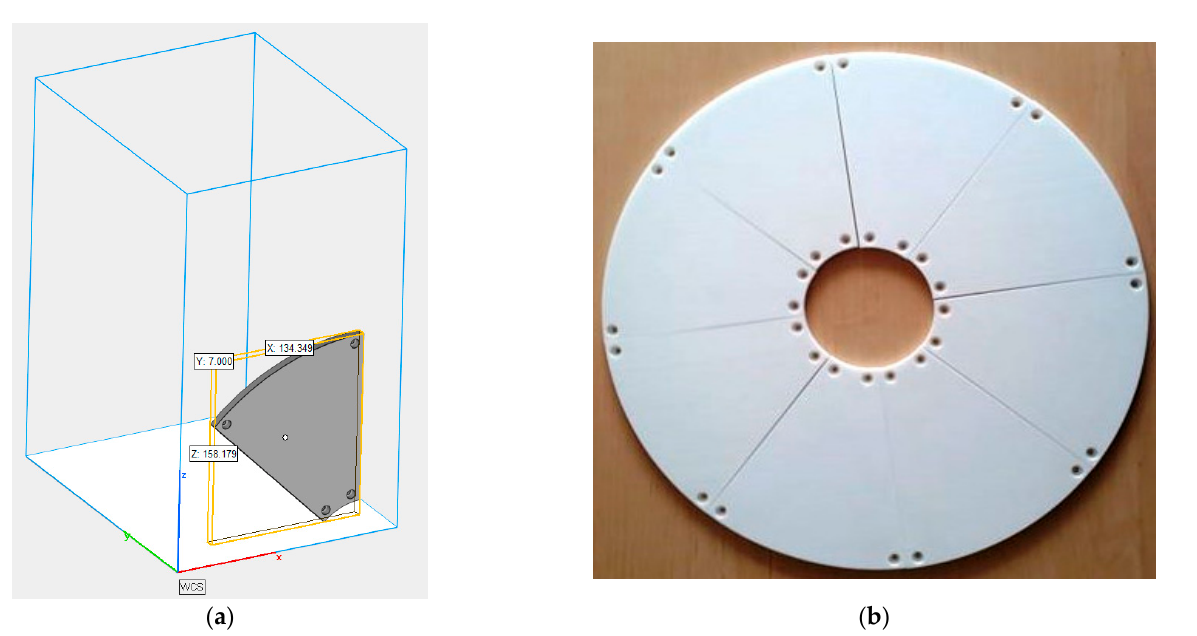
Figure 2. SLS-printed tool: ( a ) view of the printing position and dimensions of a single abrasive segment; ( b ) a prototype lapping plate consisting of eight abrasive segments.